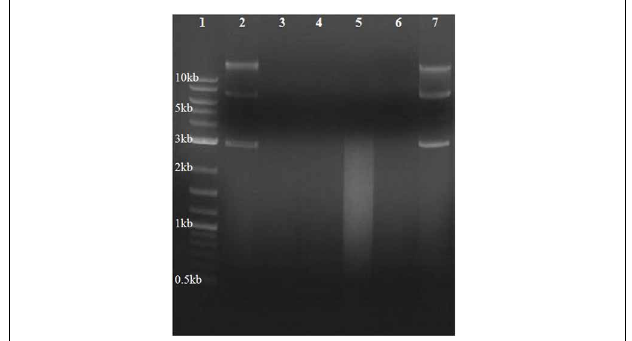
FIGURE 6 | Assay for secreted unbound nuclease activity in H. volcanii . Conditioned media was harvested from H. volcanii and S. aureus cultures, supplemented with plasmid DNA, and incubated at 37 ◦ C. Gel electrophoresis of DNA samples recovered after 12h of incubation with CM is shown. Lane numbers are (1) 2-log DNA ladder (NEB N3200L), (2) DNA incubated with unconditioned LB medium, (3) DNA incubated with DNase I,